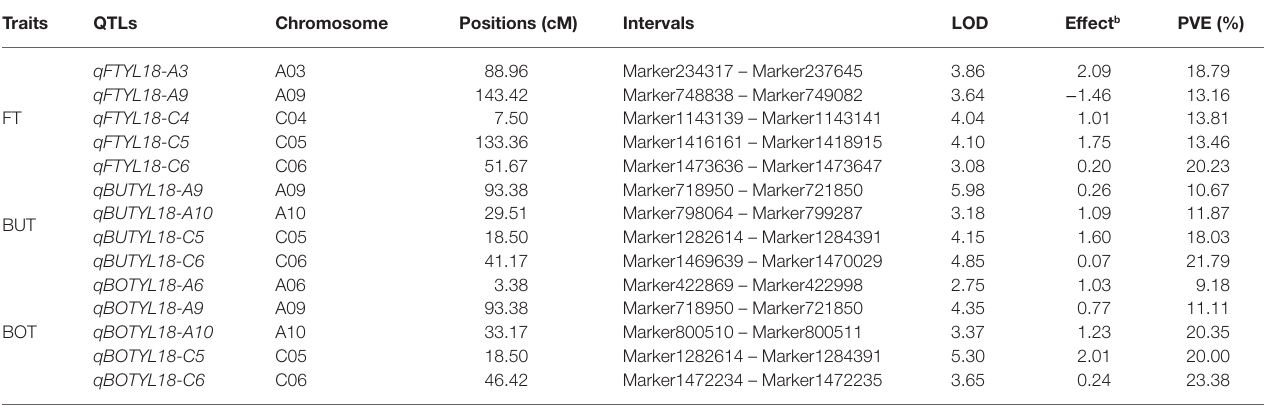
TABLE 3 | QTLs for FT, BUT, and BOT of Brassica napus basing on HRGM a .